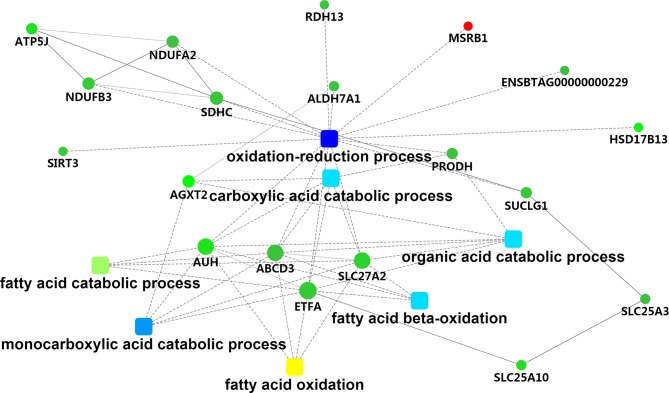
The metabolic network comprising candidate genes in PPI network and GO terms with transcriptomic analyses. Round nodes indicate genes, red indicates up-regulation, and green indicates down-regulation. The rectangular node represents the KEGG pathway/biological process, and the significant p value is represented by yellow-blue gradient; yellow indicates a small p value, while blue indicates a large p value.